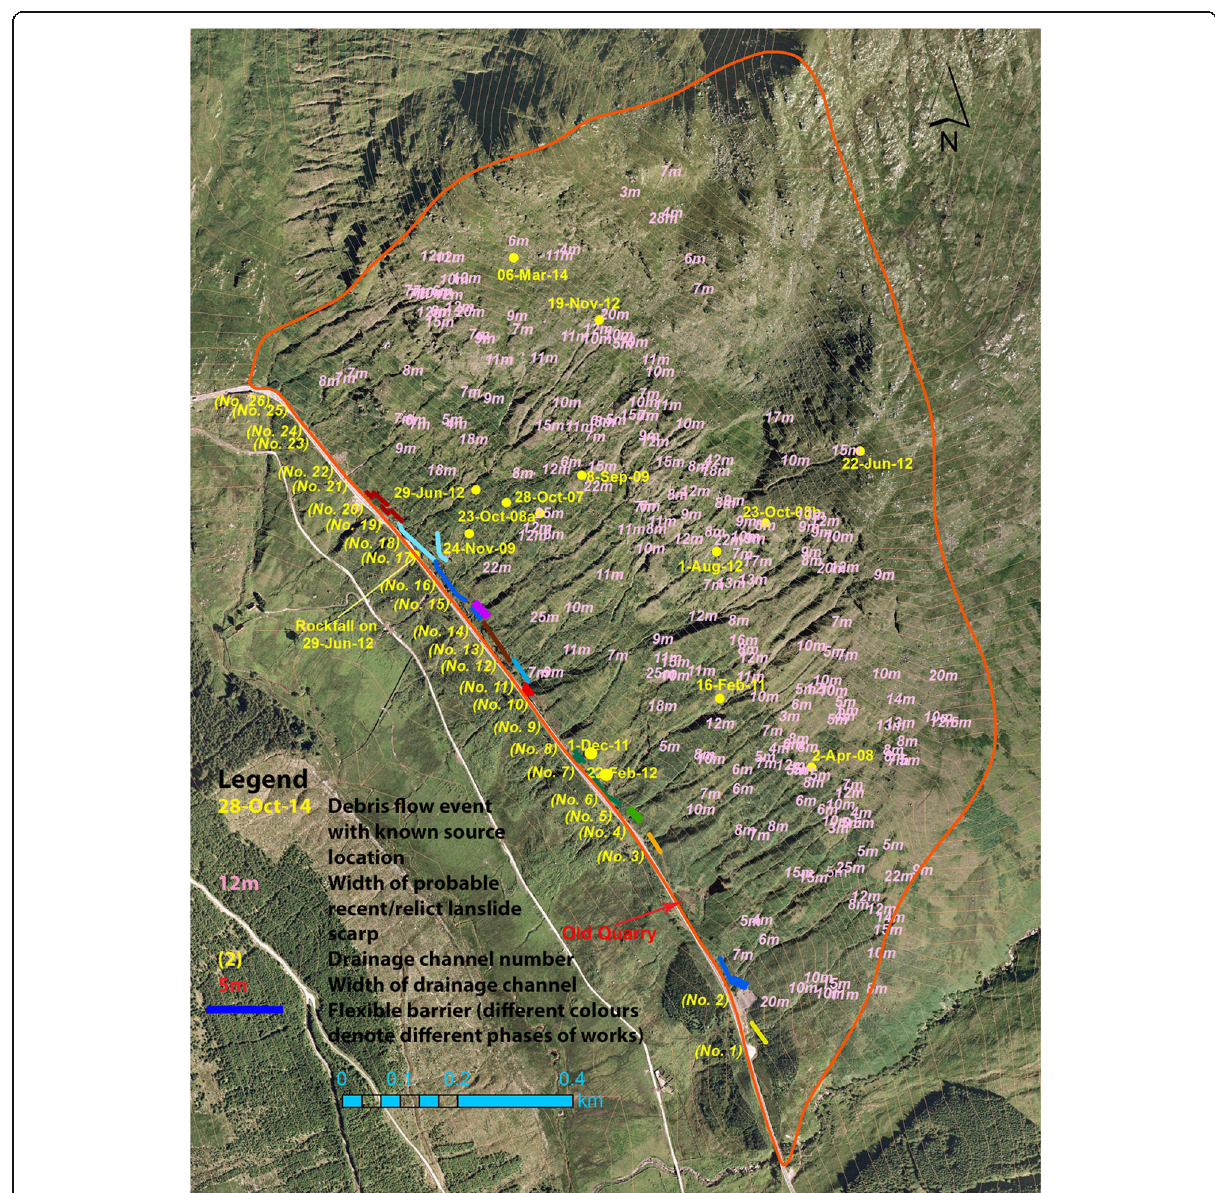
Fig. 15 Locations of the flexible barriers and catch pit at the A83 Rest and be Thankful. Base aerial photography reproduced by permission of